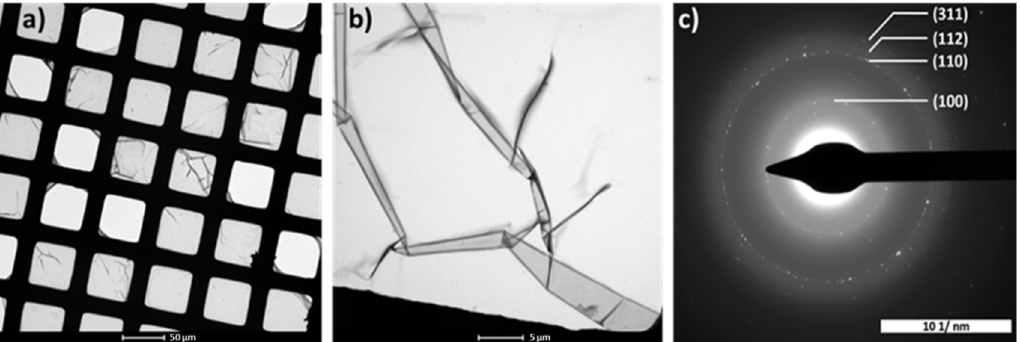
Figure 3. TEM images of EXG 3000 showing ( a ) the considerable size of the graphene flakes present in the sample at lower magnification and ( b ) their wrinkled nature at higher magnification. ( c ) SAED of the sample.